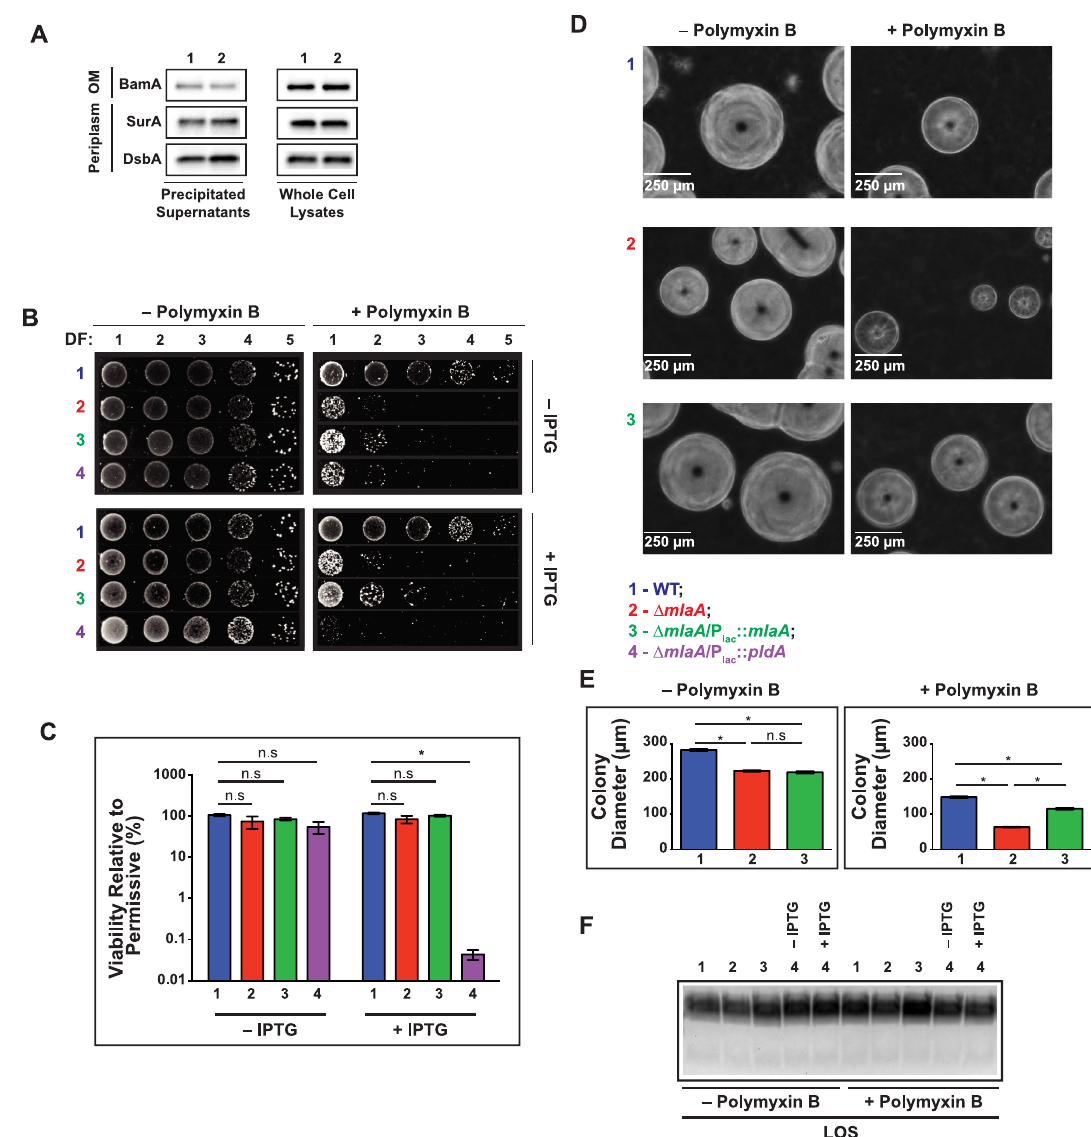
Fig 6. Loss of MlaA results in a reduction in gonococcal colony size that is exacerbated in the presence of the antimicrobial peptide polymyxin B. (A) Supernatants from mid-logarithmic cultures of WT and Δ mlaA bacteria were separated by low-speed centrifugation and filtration, treated with DNAseI, and precipitated with a pyrogallol red-molybdate-methanol procedure. Precipitated supernatants and whole cell lysates were standardized by the OD 600 of the source culture, separated by SDS-PAGE, and probed with indicated antisera. (B) WT FA1090, isogenic knockout Δ mlaA , complementation strain Δ mlaA /P lac :: mlaA , and PldA overexpression strain Δ mlaA / P lac :: pldA were cultured aerobically in liquid medium for 3 h, back diluted to an OD 600 of 0.1, cultured 2 h longer, serially diluted, and spotted onto GCB without (left column) or with (right column) polymyxin B (800 U/mL) and either without (top row) or with (bottom row) 0.5 mM IPTG. Dilution spots from each condition were imaged with a Bio-Rad ImageDoc system. (C) CFUs for permissive and restrictive conditions with or without IPTG were counted and relative viability was calculated. Experiment was performed on three separate occasions (mean ± SEM on graph; � p < 0.05), and typical plate images are presented. (D) Representative micrographs from 10 − 4 dilution taken with a Zeiss AxioObserver.D1 microscope at 10 × magnification 0.25 Phase Contrast 1 of WT (Row 1), Δ mlaA (Row 2), and Δ mlaA /P lac :: mlaA (Row 3). MlaA expression was induced by inclusion of 0.1 mM IPTG in the solid medium for the complementation strain. (E) Images of 10 − 4 dilution were also taken at 2.5 × magnification 0.06 Phase Contrast 1 and colony diameters were measured with ImageJ software. Colonies were measured for each of two independent experiments for the − polymyxin B condition (WT, n = 548; Δ mlaA , n = 755; Δ mlaA /P lac :: mlaA , n = 664) and for the + polymyxin B condition (WT, n = 836; Δ mlaA , n = 1197; Δ mlaA /P lac :: mlaA , n = 1121; mean ± SEM on graphs; � p < 0.05). (F) Rapidly growing liquid cultures of WT, Δ mlaA , Δ mlaA /